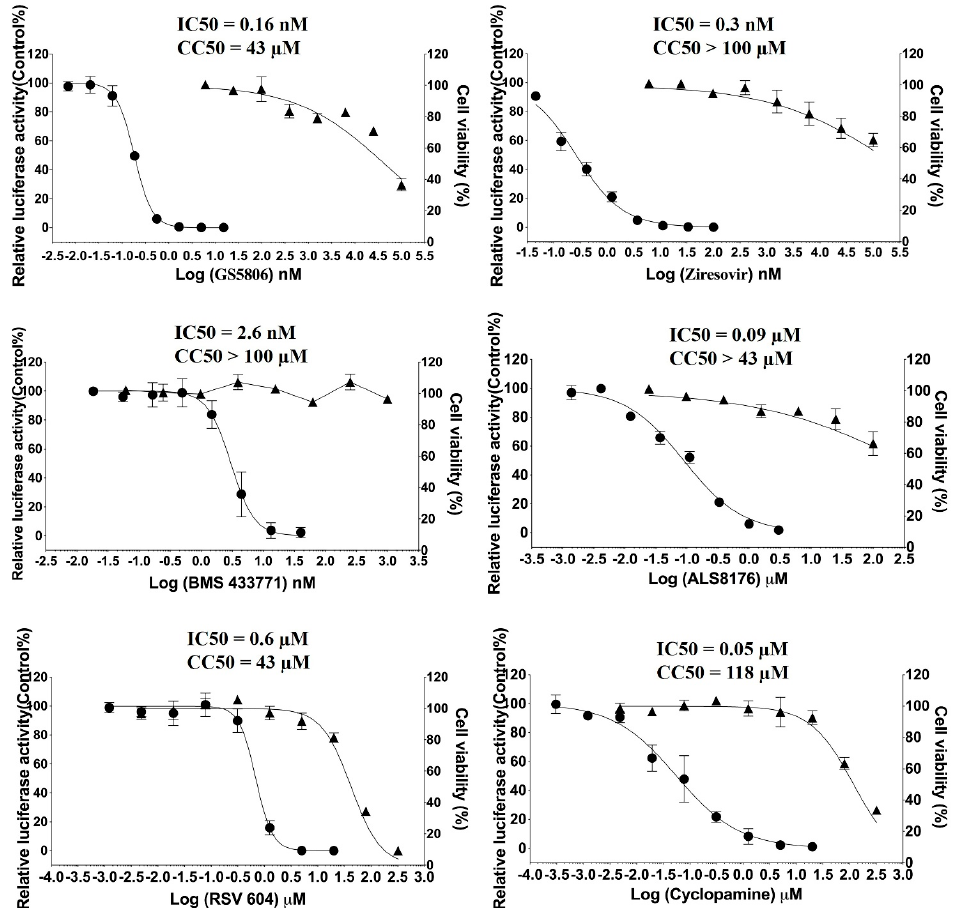
Figure 2. Antiviral activity of selected inhibitors. HEp-2 cells in 96-well plates were infected with respiratory syncytial virus (RSV)–Luc strain in the presence of various dilutions of selected compounds or DMSO control. Luciferase activity (•) was measured, normalized, and expressed as % of DMSO control. The cytotoxicity ( ▲ ) of compounds was measured in parallel in the same cells. The results are representative of three independent experiments performed in triplicate (mean ± s.d.).